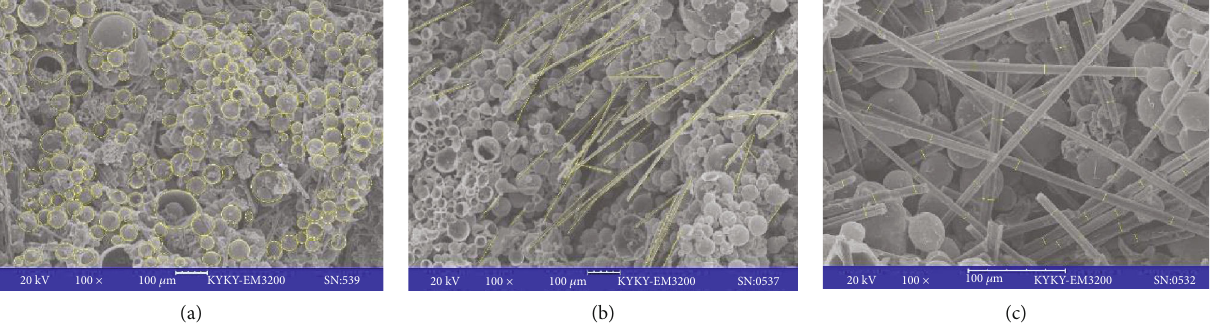
Figure 1: Microstructure image of thermal insulating